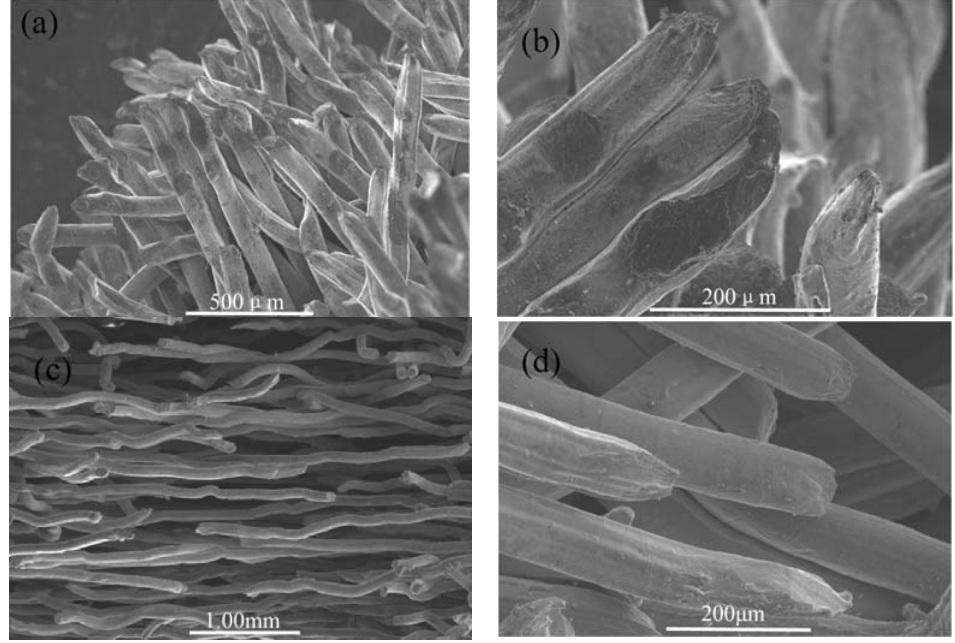
Figure 5. SEM images of the failed wires in the PTWMs. ( a ) and ( b ) 45° angle fracture mode; ( c ) and ( d ) auxetic failure